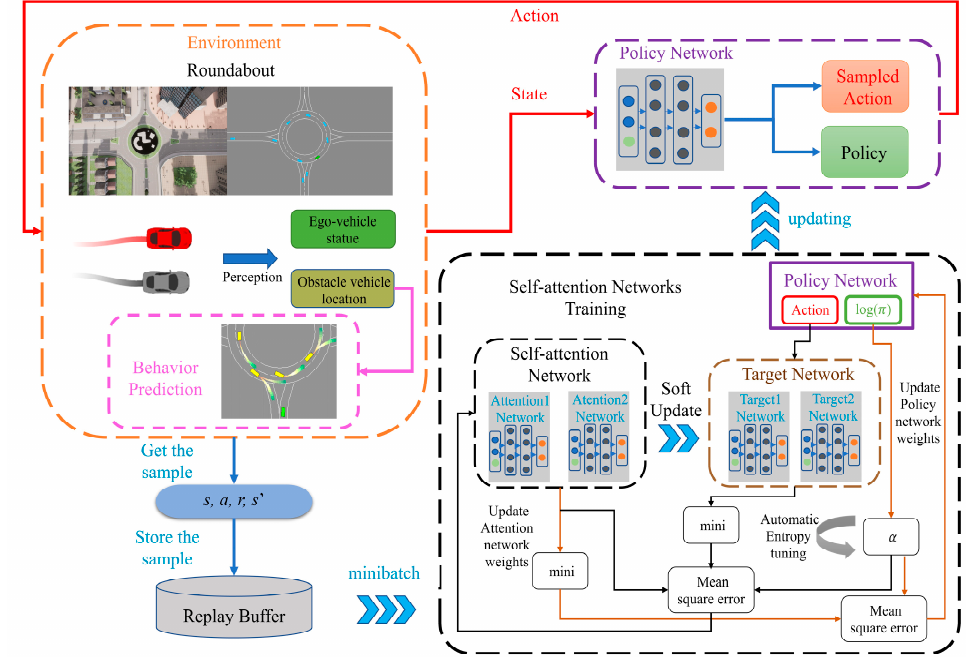
Figure 2. The proposed IP-SAC framework. Table 3. Training hyperparameters and neural network structure.